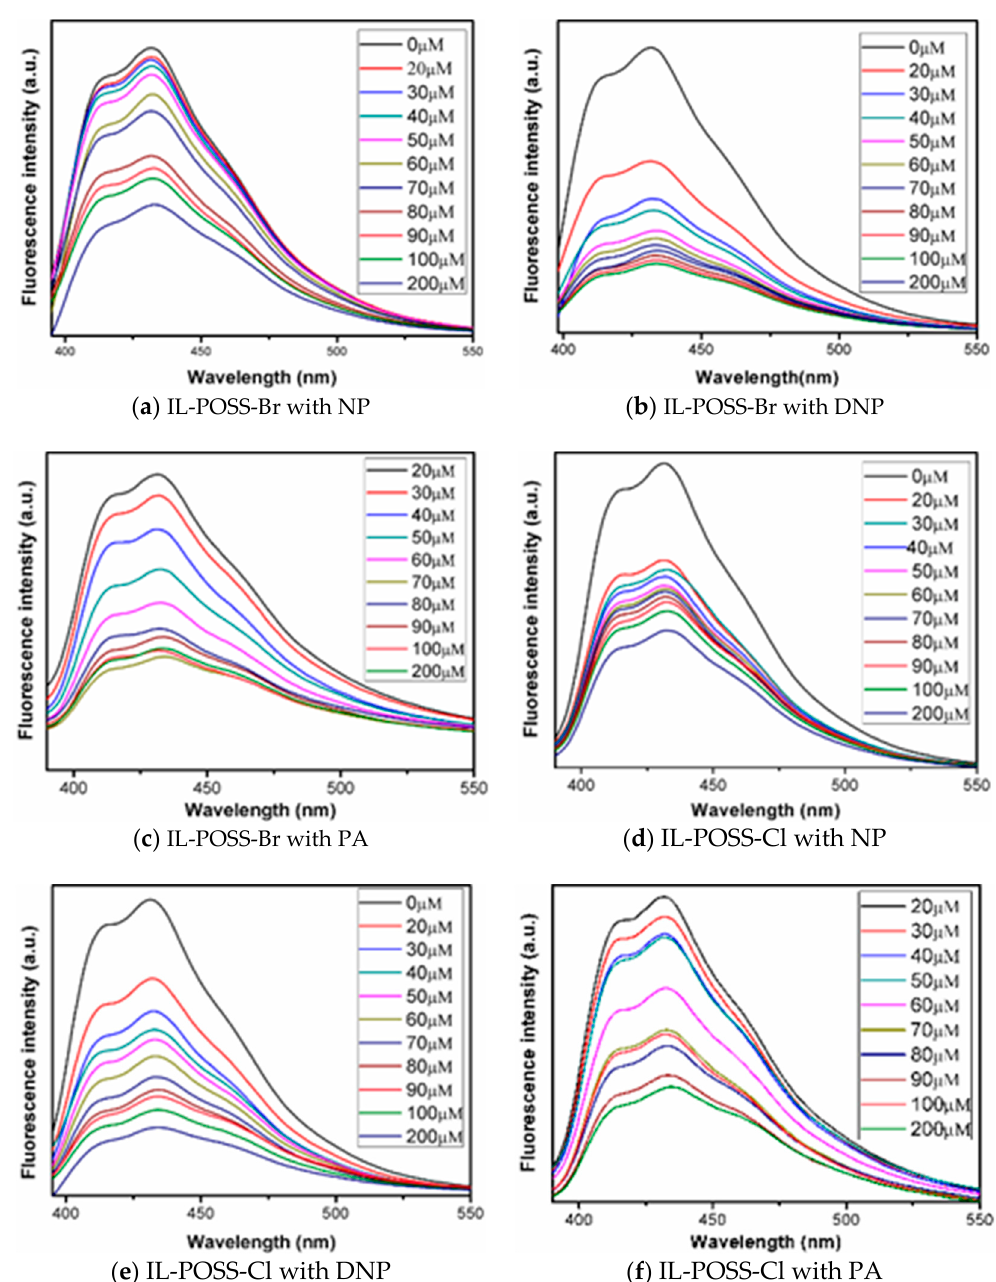
Figure 3. Emission spectra ( a – c ) belong to IL-POSS-Br upon the addition of 4-nitrophenol (NP), 2,4-dinitrophenol (DNP) and picric acid (PA) ethanol solution, respectively. Emission spectra ( d – f ) belong to IL-POSS-Cl upon the addition of NP, DNP, and PA, respectively.